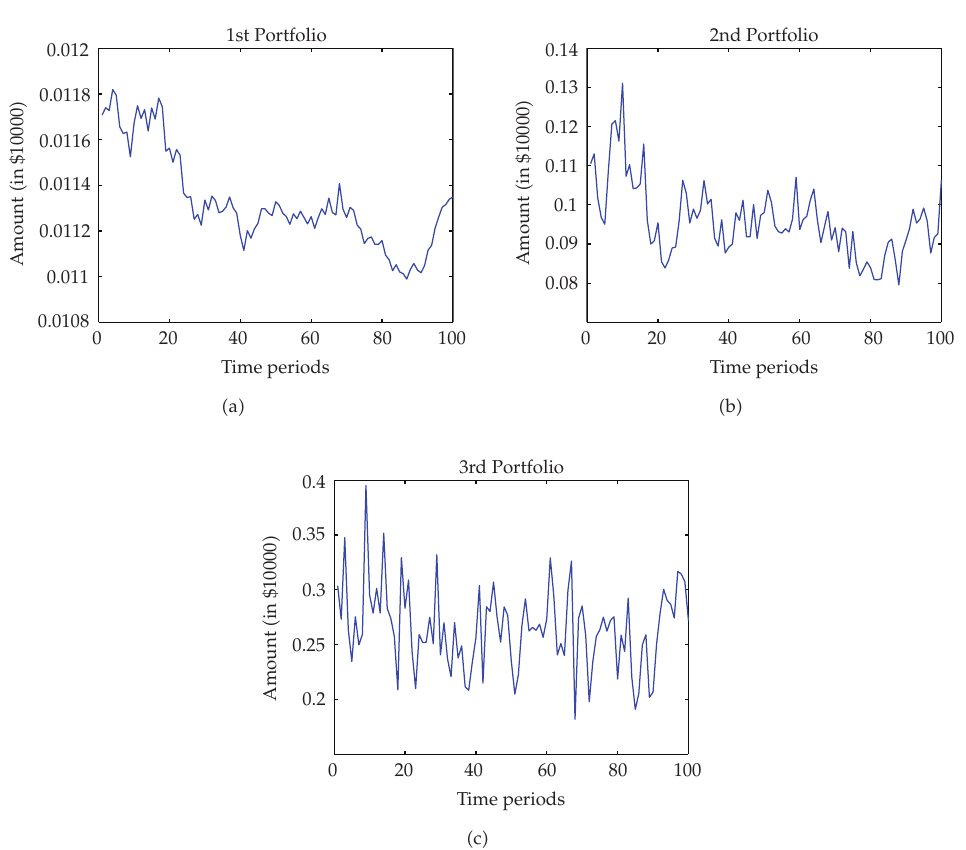
Figure 4: The evolution of the 1st, 2nd and 3rd classes of a heterogeneous Portfolio for the respective incidents, during 100 unit-time period.